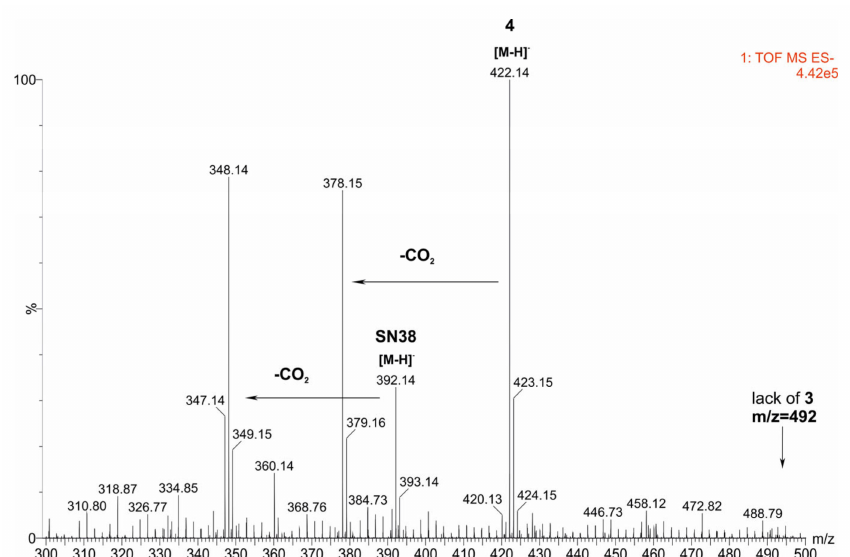
Figure 7. The ESI–MS spectrum (in the m / z range 300–500) of negative ions of a mother liquor of 24- 13 C-enriched compound 3.